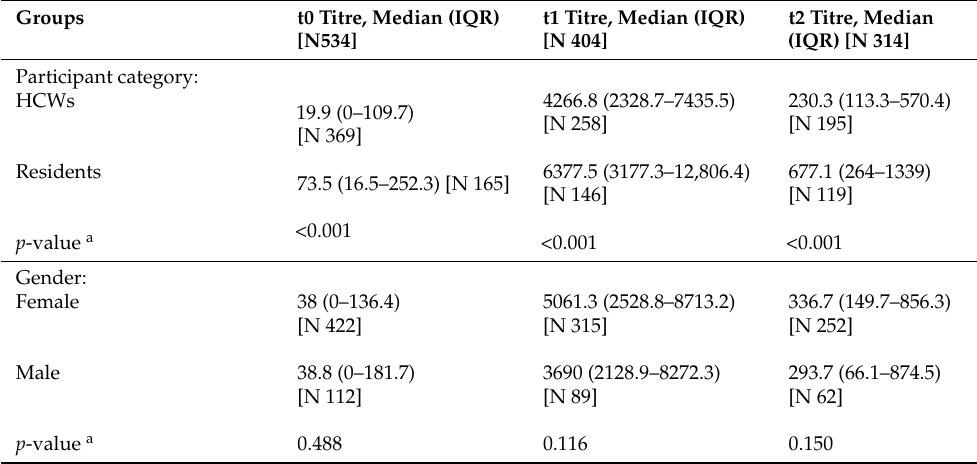
Table 2. Anti-SARS-CoV-2 IgG titres (BAU/mL) of study participants, overall and stratified according to groups, Piedmont, Italy, 2021 (t0: N = 534, t1: N = 404, t2: N =